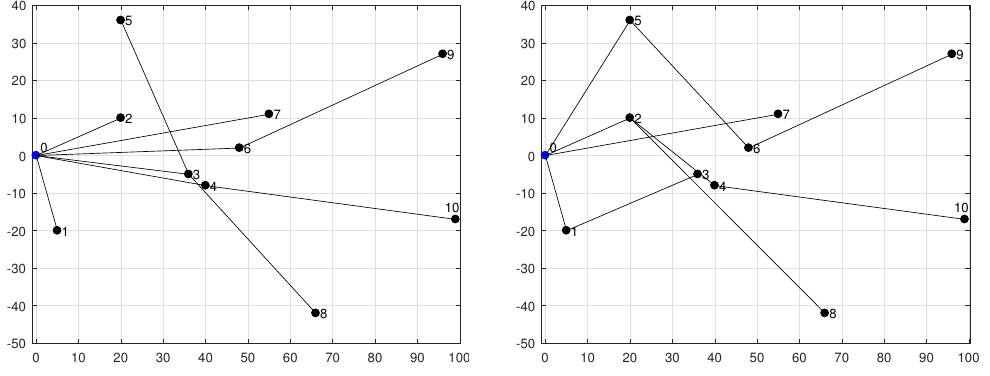
Figure 9. 10-node topologies after simulation with DC = 3% ( left ) and DC = 10% ( right